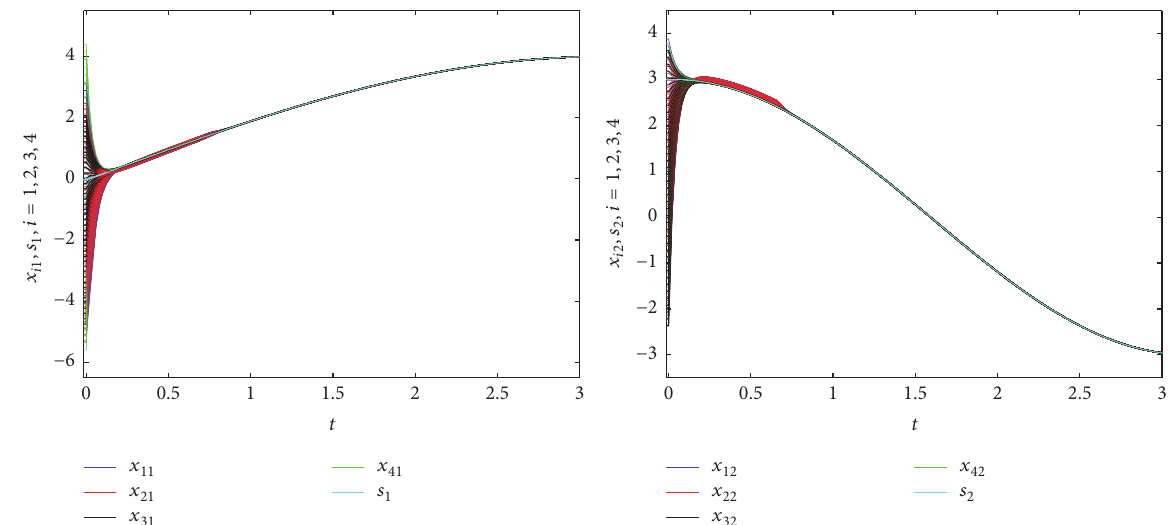
Figure 8: Finite-time synchronization curves of 𝑥 𝑖𝑗 for (68) with different initial